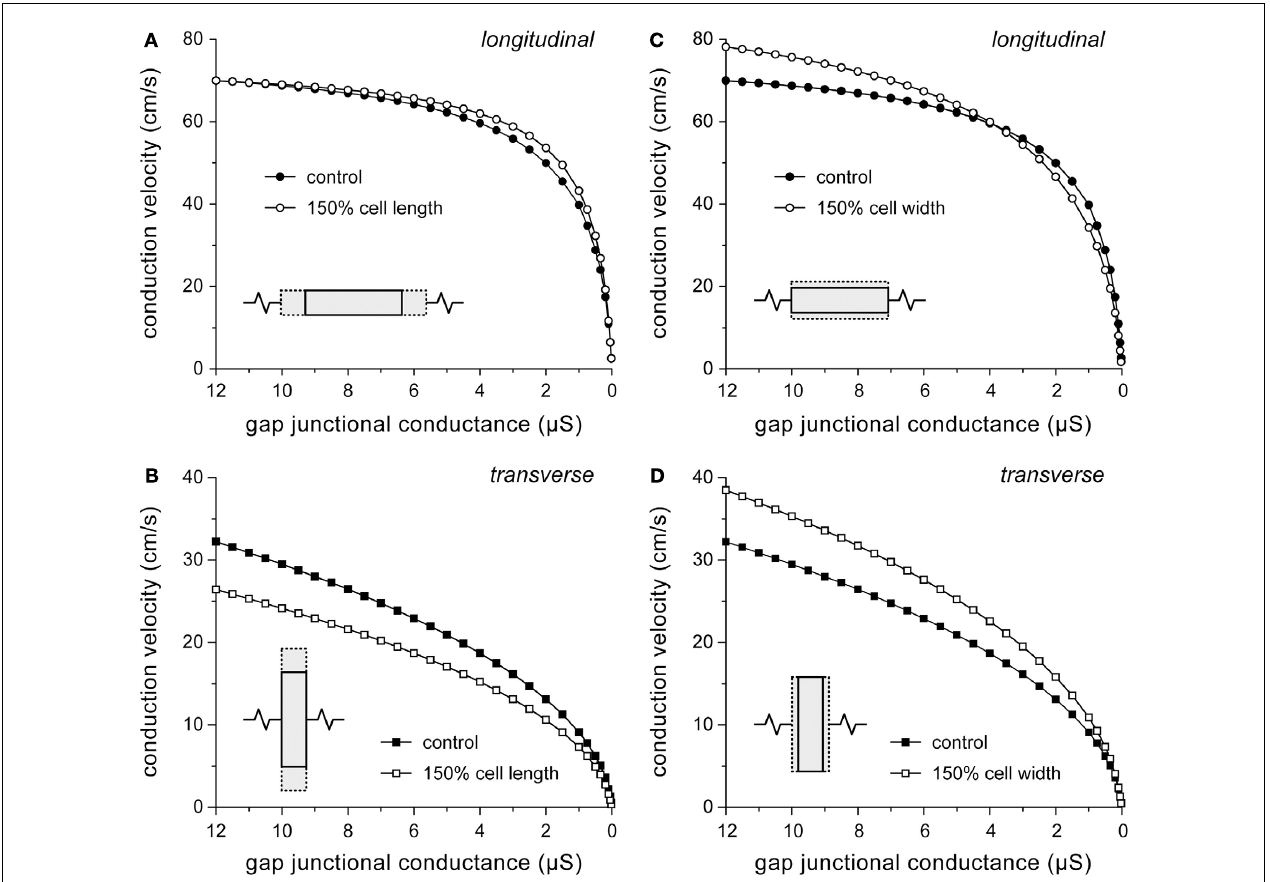
FIGURE 4 | Effect of changes in cell dimensions on conduction velocity. (A,B) Effect of 50% increase in cell length on (A) longitudinal and (B)